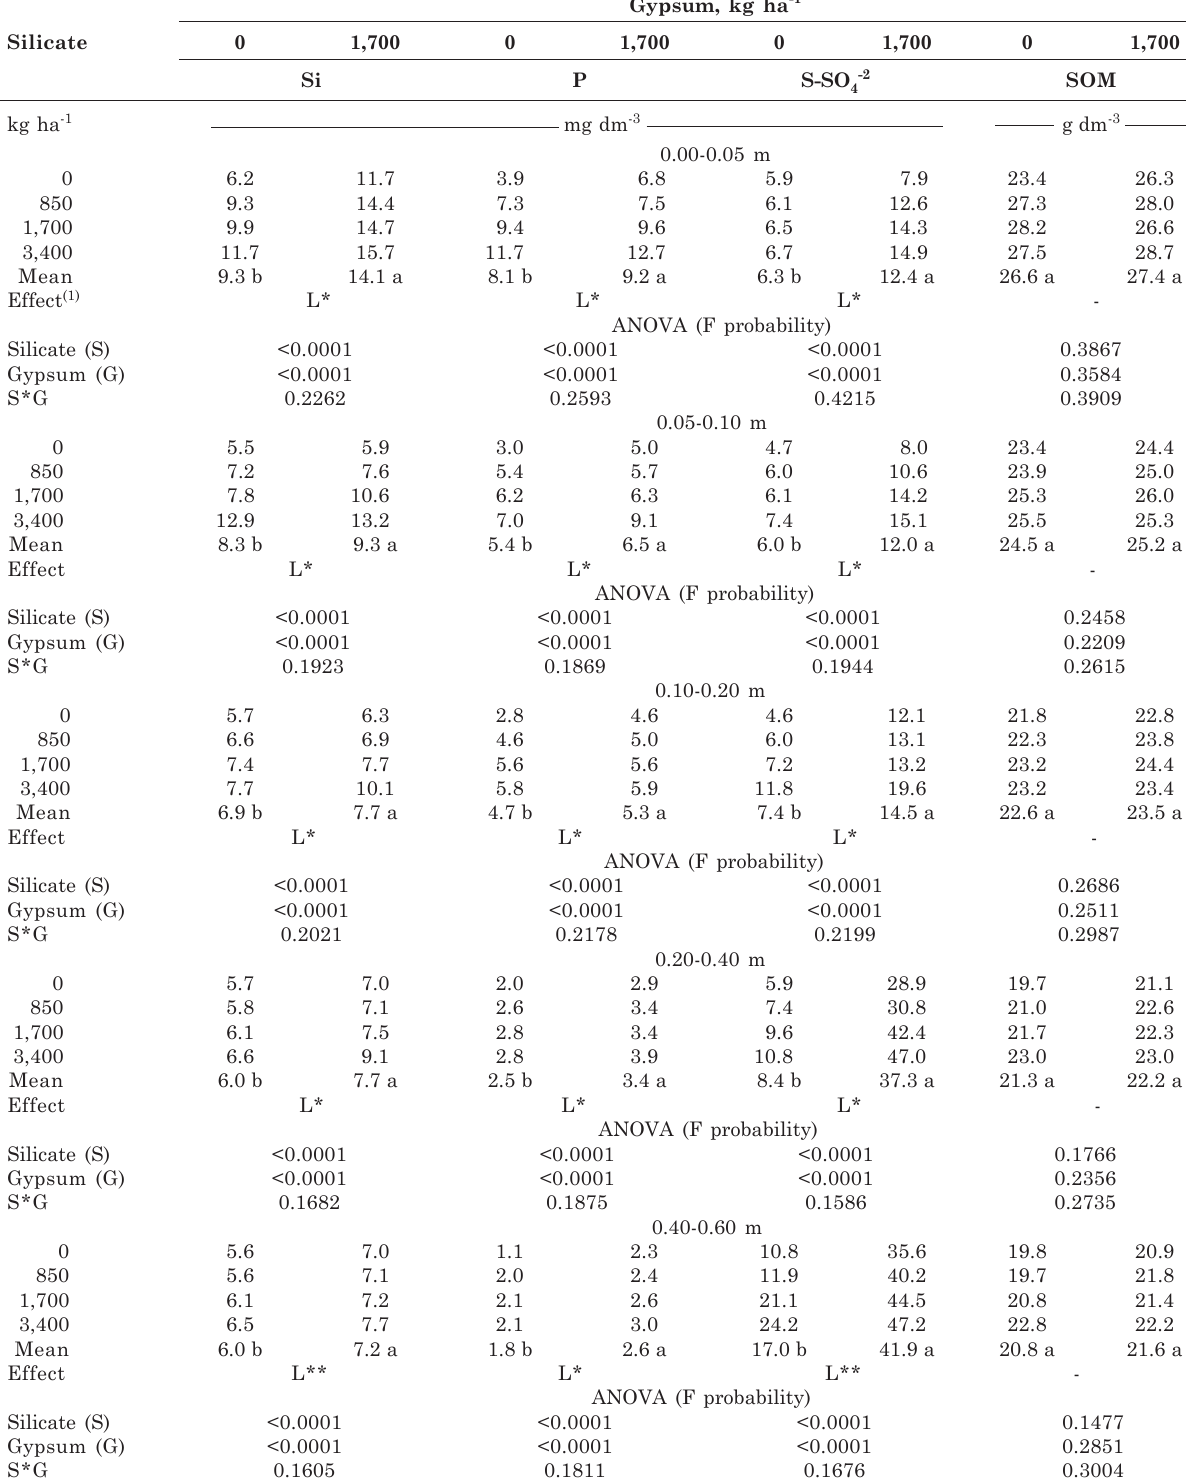
Table 3. Values of Si, P, sulfate and soil organic matter (SOM) of soil samples taken 12 months after Ca-Mg silicate and gypsum surface application on green sugarcane, and ANOVA significance at five soil